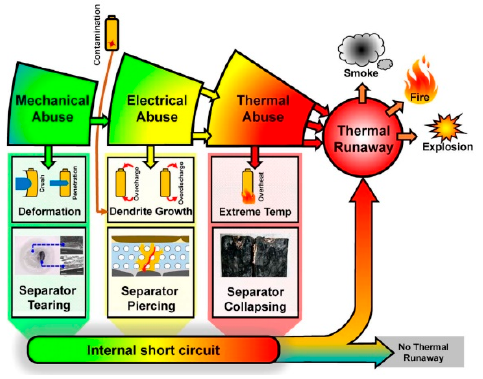
Figure 11. ISC, the most common feature of TR [31].